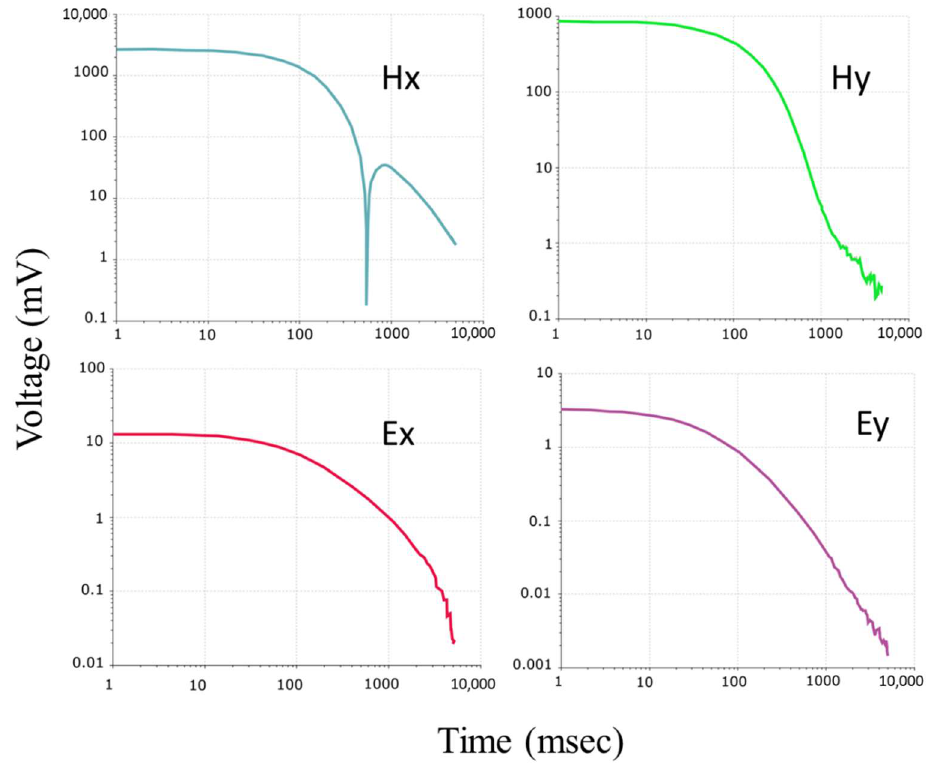
Figure 9. Transients in log scale from site ST-04, showing magnetic field and electric fields.